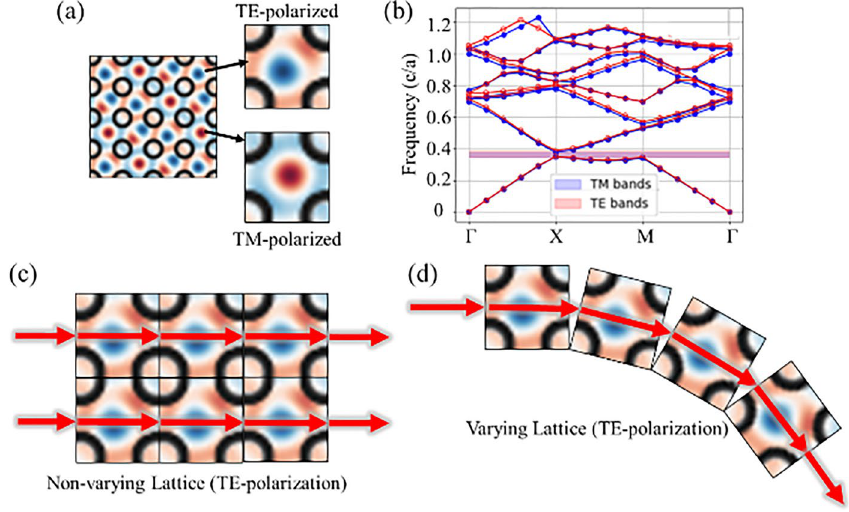
Figure 2. IFC and bandgap simulation results with impact on beam propagation. ( a ) IFCs on non-varying PC lattice for both TE and TM polarization. ( b ) Resulting bandgap of unit cells for non-varying PC lattice. ( c ) Theoretical beam propagation through PC without spatial variation for TE polarization. ( d ) Theoretical beam propagation through PC with spatial